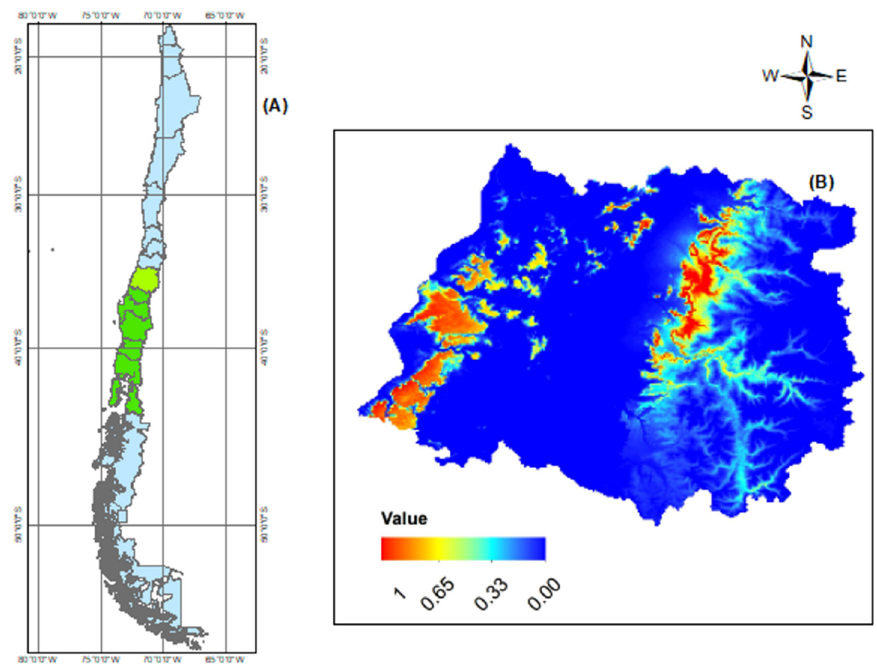
Figure 3. Maps of distribution of G. avellana. ( A ) Current distribution in Chile (Green area) and ( B ) potential current habitat suitability in Maule Region; while closest to “1”, the highest is the suitability for G. avellana .